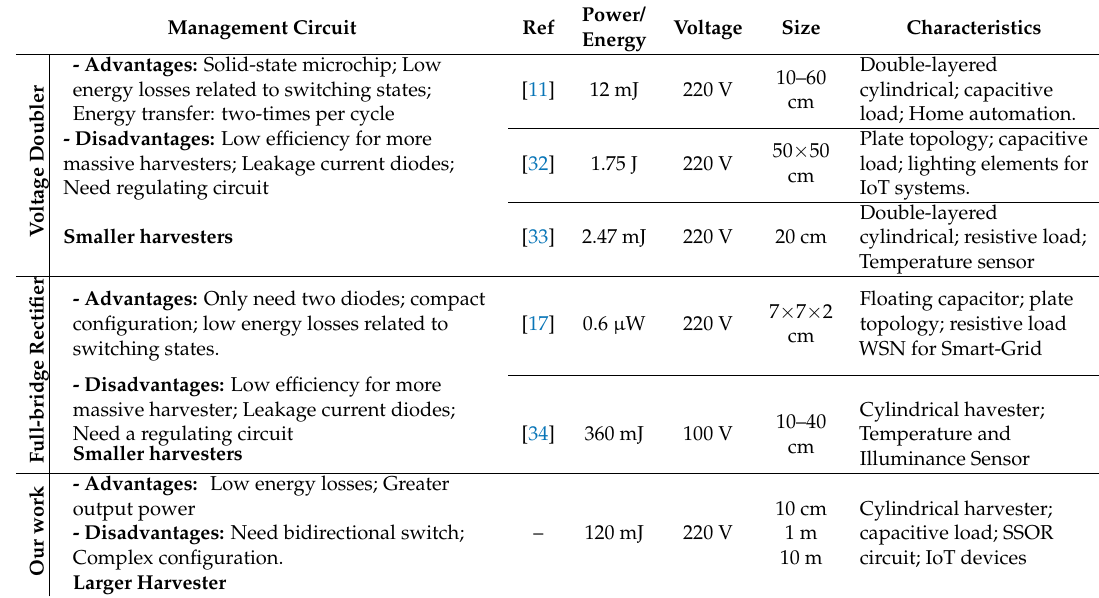
Table 3. Comparison of the existing power management